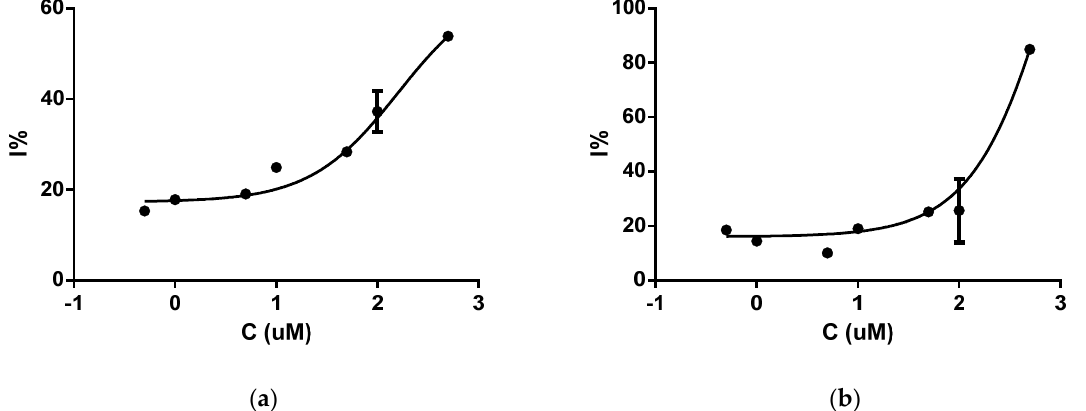
Figure 1. The plotted sortase A inhibition (I%) against compounds logarithm of concentration (µM): ( a ) compound 1 ; ( b ) compound 2 .